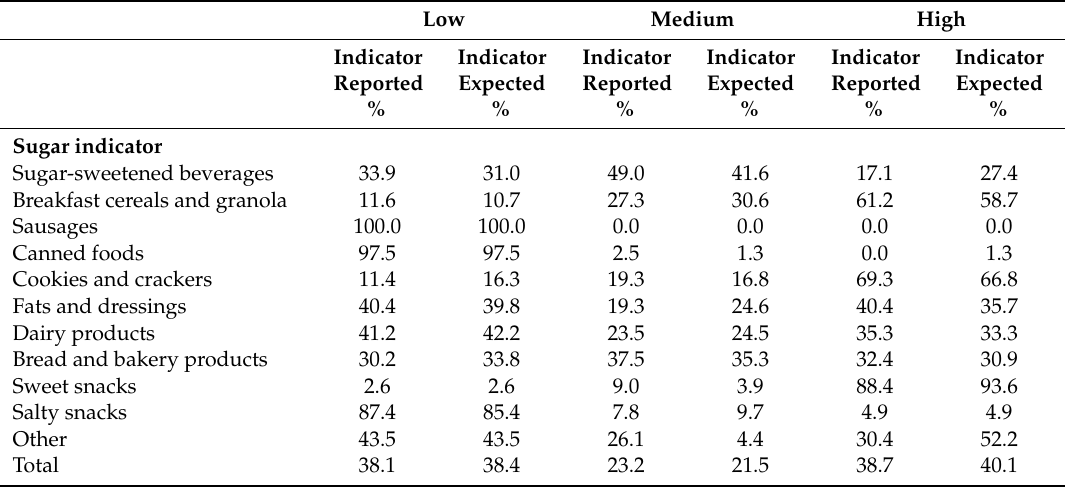
Table 3. Proportion of TL indicators reported on the label and indicators expected by product